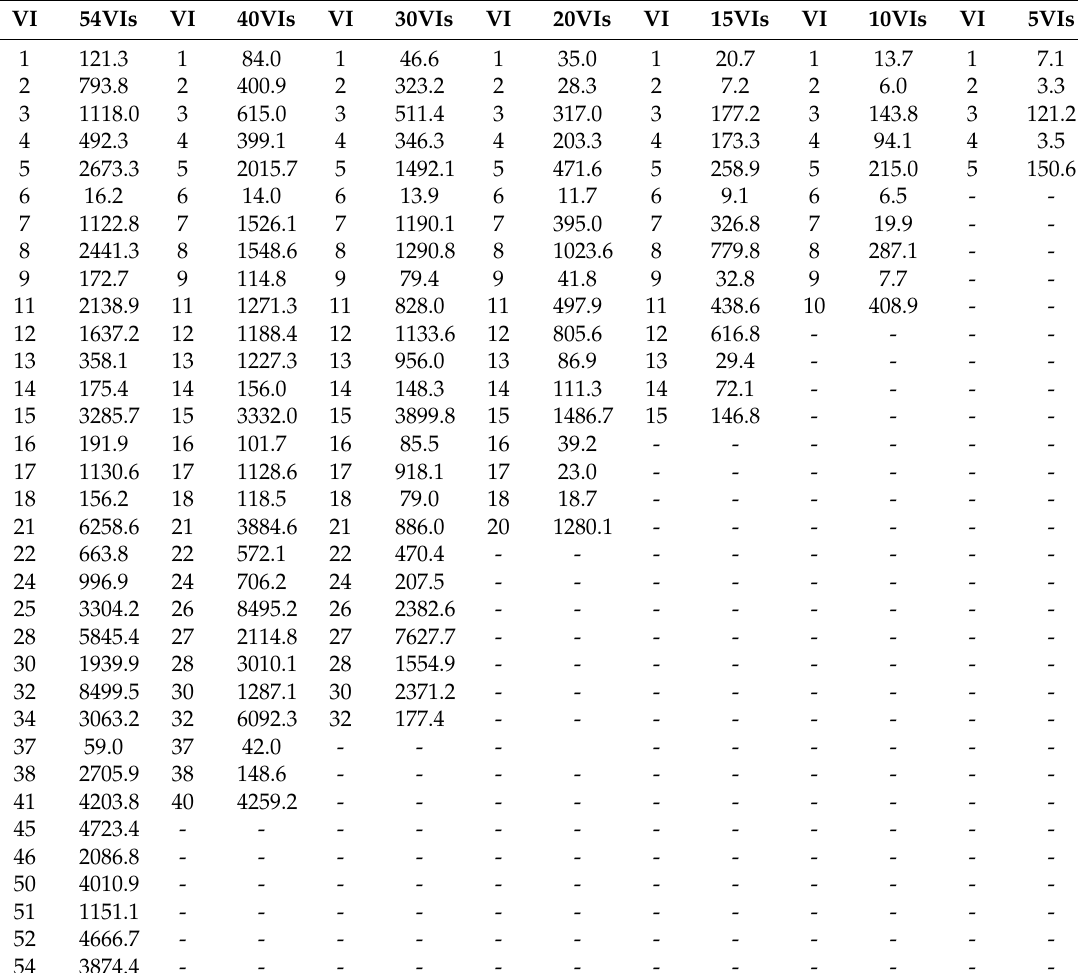
Table A2. Variance inflation factor (VIF) of